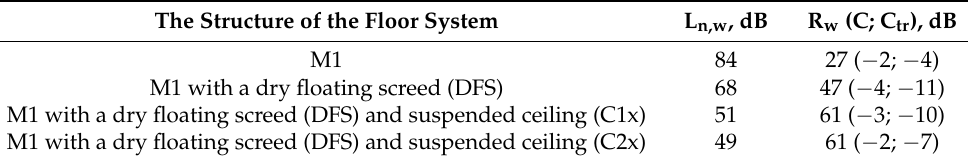
Table 5. Single number values for the M1 panel with a dry floating screed (DFS) and a suspended ceiling.